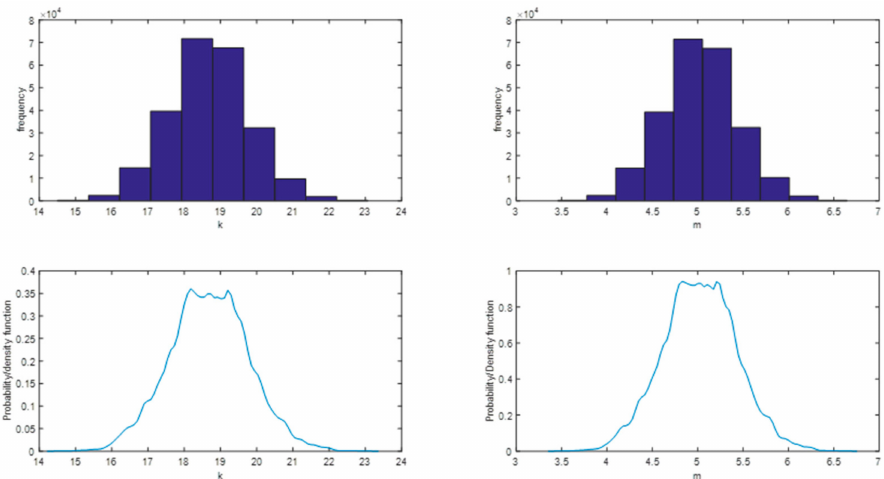
Figure 6. Posterior marginal density functions: ( a ) k ; ( b ) m .